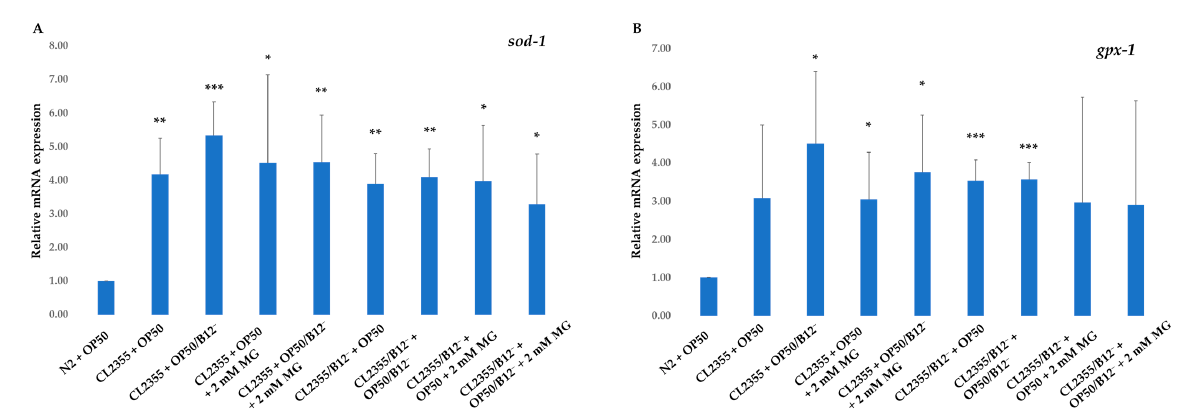
Figure 4. Expression of sod-1 ( A ), gpx-1 ( B ), ctl-1 ( C ) and gst-10 ( D ) genes on N2 and N2/B12 − fed with either OP50 or OP50/B12 − with or without 2 mM mogrosides. The fold-change (2 −ΔΔ Ct ) and standard deviations of the gene expression were calculated from five independent experiments. All treatments were compared to control N2 + OP50. The Student t -test was conducted to assess statistical significance (* p < 0.05; ** p < 0.01; *** p < 0.001).